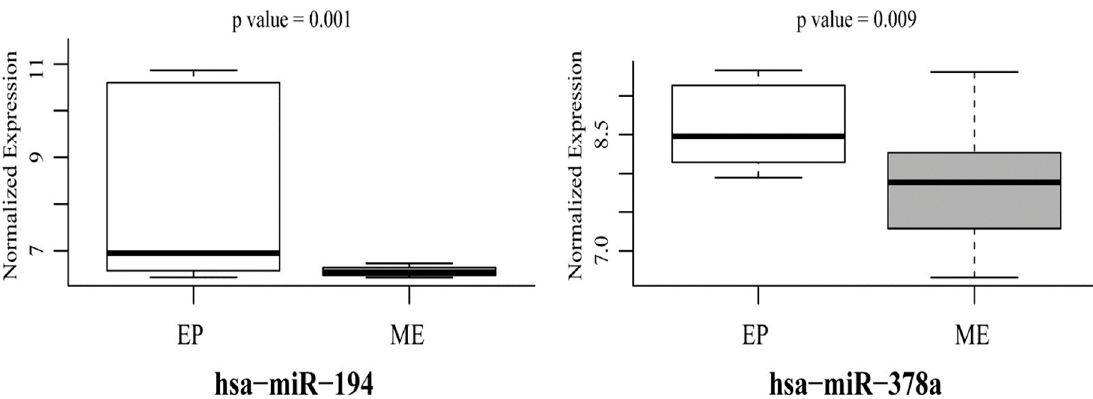
Figure 7. GOF Mutant p53 R273H -regulated miR-194 and miR-378a is down-regulated in NCI-60 cell lines with mesenchymal phenotype. Box-Whisker plots showing relative expression of miR-194 and miR-378a in mesenchymal and epithelial groups of NCI-60 cell lines. p-values are indicated.